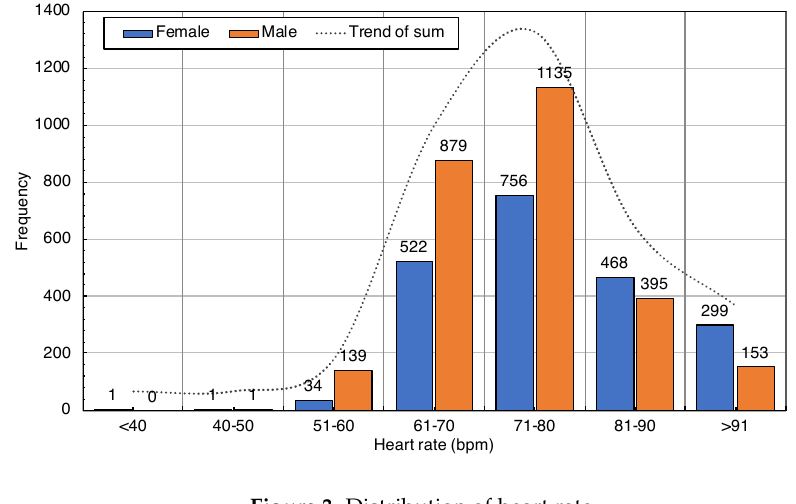
Figure 3. Distribution of heart